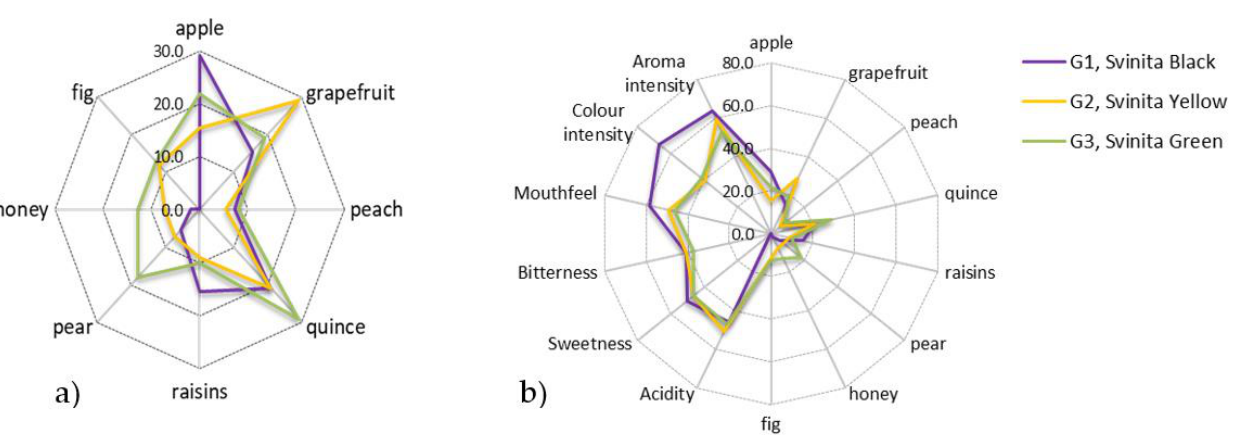
Figure 6. Intensity of the perceived aroma attribute ( a ) and principal component analysis based on the perceived intensity of aroma attribute ( b ) for the beverages from fig varieties G1–G3.